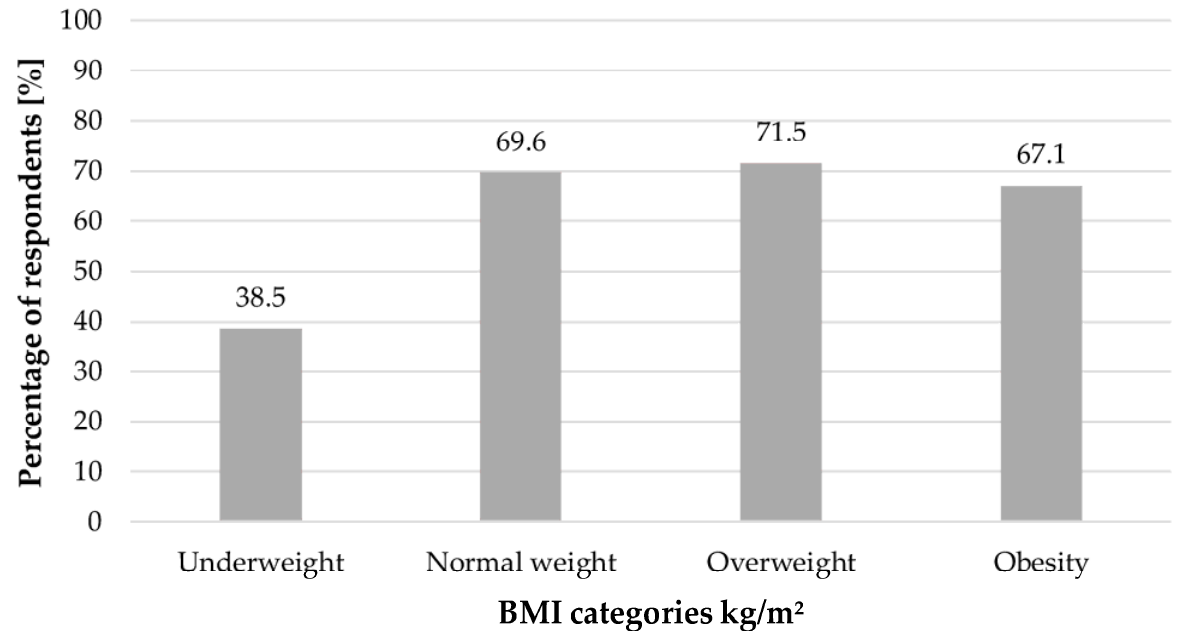
Figure 1. The level of physical activity depending on BMI ( p < 0.001).